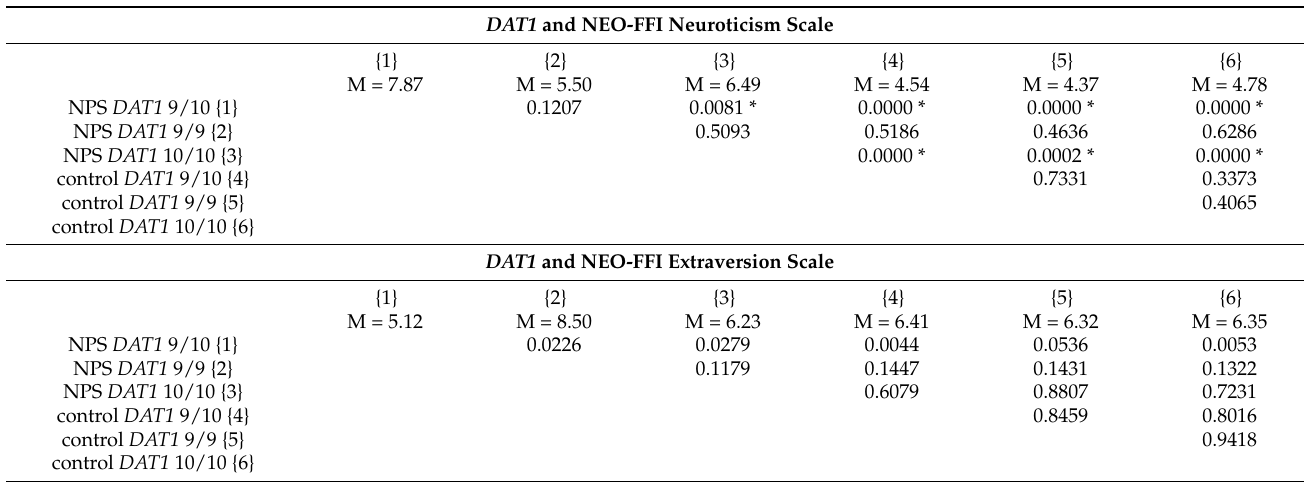
Table 5. Post hoc analysis of interactions between users of ‘new psychoactive substances’ (NPS)/controls, DAT1 polymor- phisms, and the NEO-FFI neuroticism/extraversion